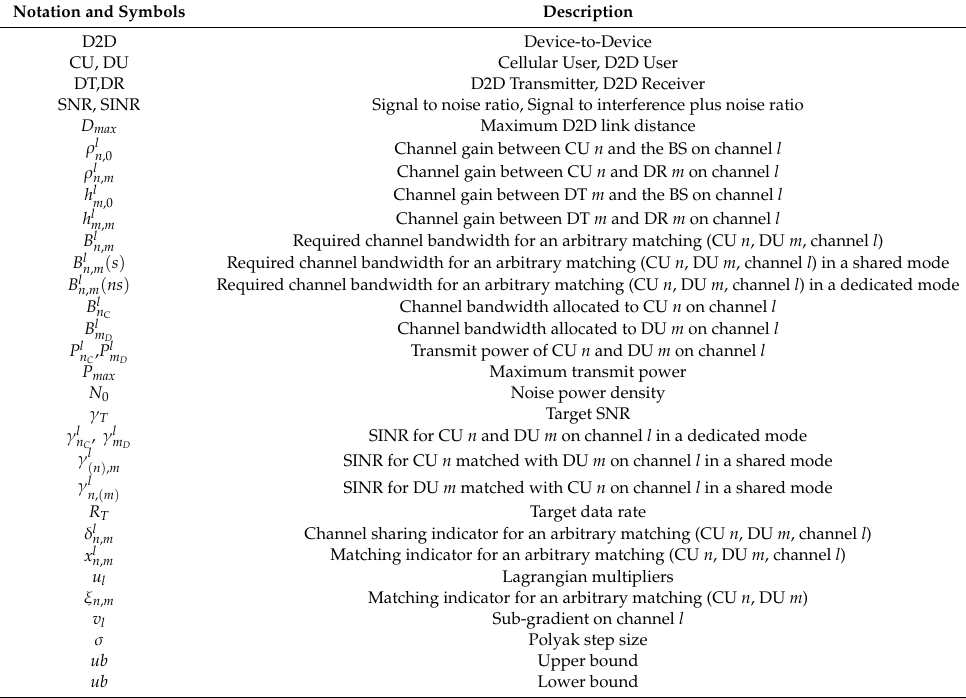
Table A1. A list of the notations and